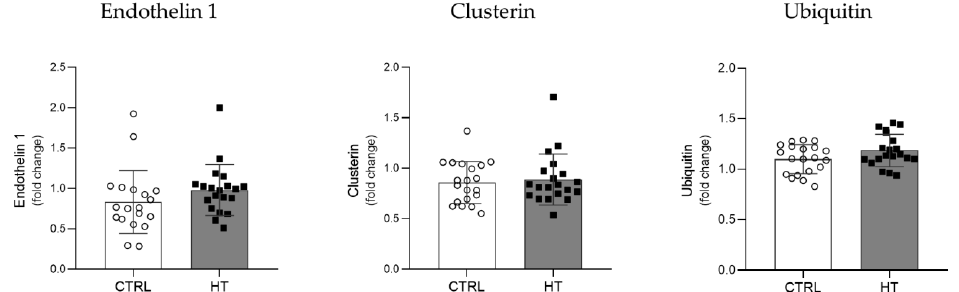
Figure 2. Levels of vasoconstrictor and proteostasis-related proteins in the plasma of control and individuals with hypertension. Plasma levels of Endothelin 1, Ubiquitin, and Clusterin were analysed by slot blot immunoassay. Two-tailed unpaired t -tests or Mann – Whitney tests were applied to compare both groups of individuals: controls (CTRL, ○ ) and individuals with hypertension (HT, (cid:4) ). All samples were normalized to the reference sample and protein levels are represented as fold changes relative to this reference sample.